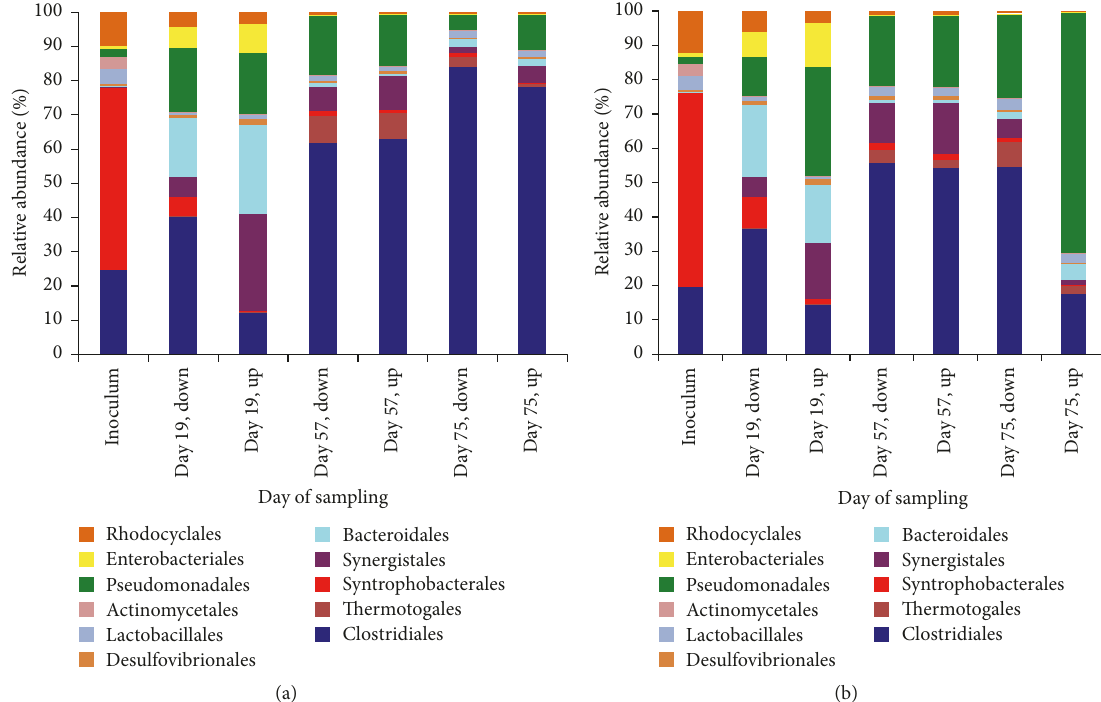
Figure 4: Microbial dynamics on order level for UASB reactor 1 (a) and reactor 2 (b), digesting microalgal biomass and sodium acetate.